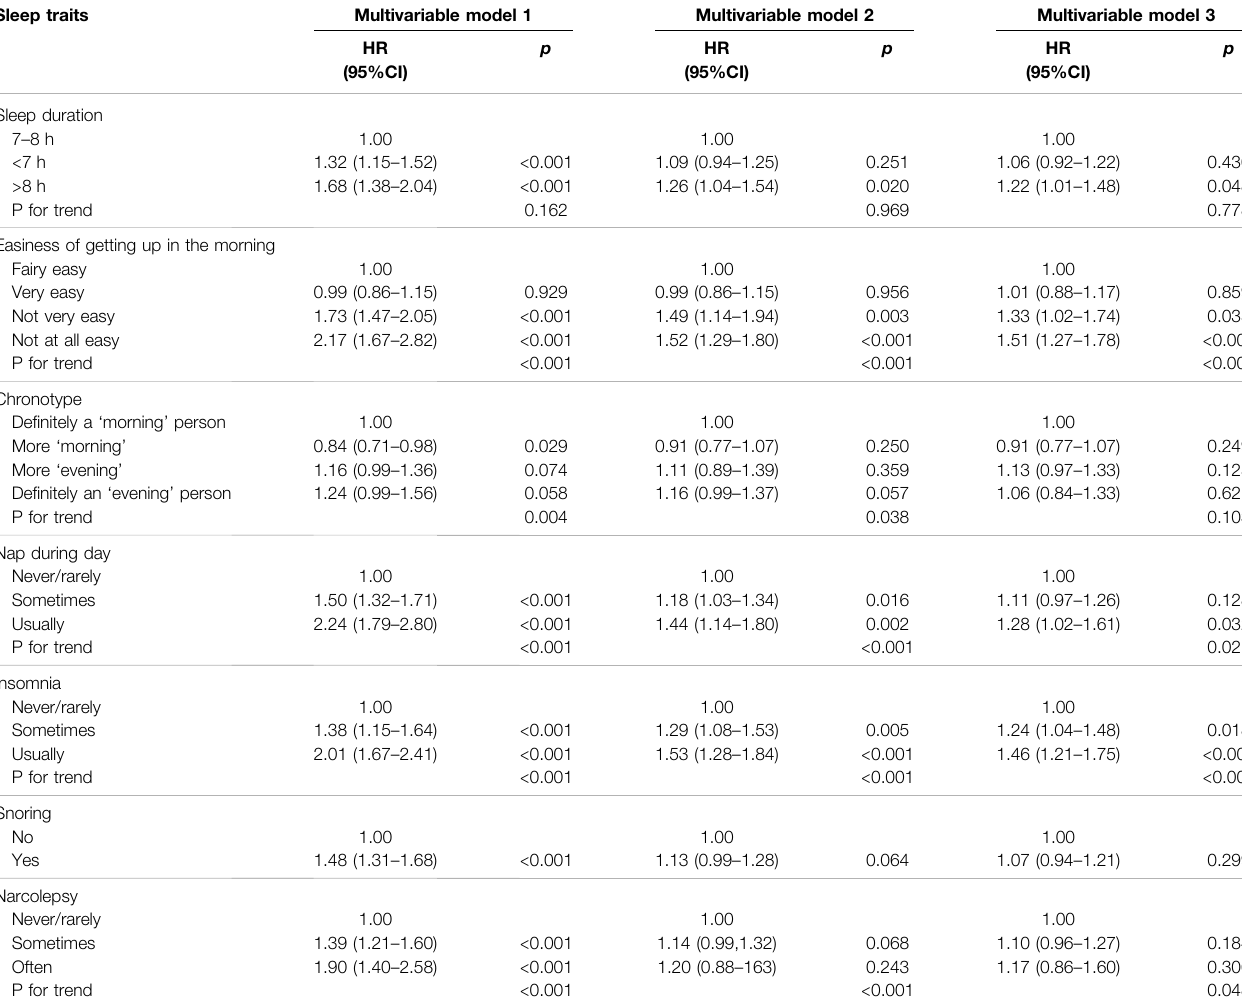
TABLE 2 | Multivariable Cox proportional hazards model analysis for risk of nonalcoholic fatty liver disease and sleep traits (7 × 3 different models). Sleep